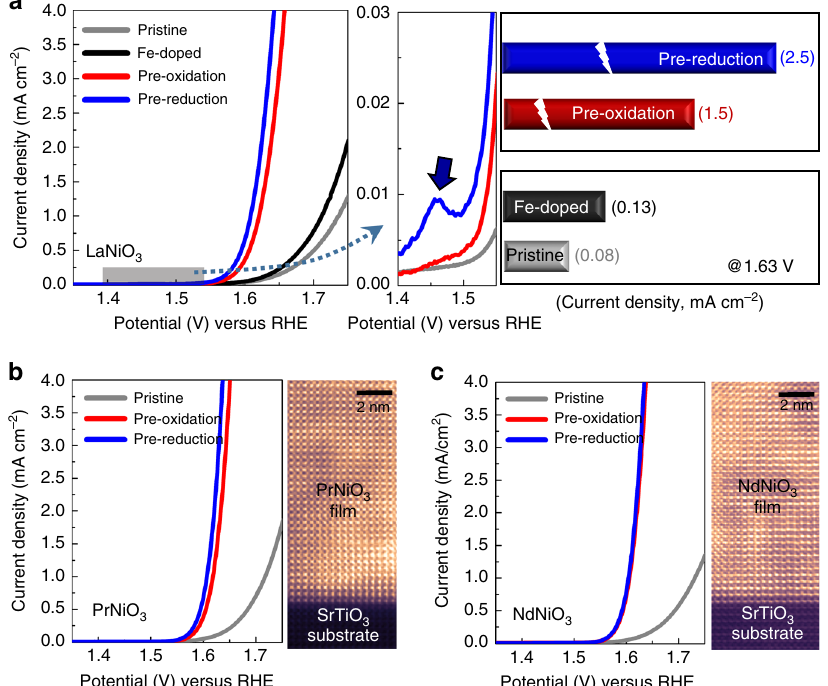
Fig. 3 Comparison of OER current densities. a Remarkably high OER activities were obtained in the LaNiO 3 fi lms following the surface Fe exchange that occurred with the pre-reduction and pre-oxidation reactions. Note the much larger OER current values of the surface-Fe-exchange fi lms compared with the current value of the La(Ni,Fe)O 3 solid-solution fi lm, as speci fi cally compared in the bar graph. The small peak indicated by a black arrow in the blue curve in the middle column represents the occurrence of the Ni 2 + /Ni 3 + oxidation reaction. b , c Remarkably enhanced OER activities were consistently identi fi ed in both PrNiO 3 and NdNiO 3 fi lms following the surface Fe exchange. HAADF images also demonstrate the epitaxial growth of the fi lms along with high crystallinity